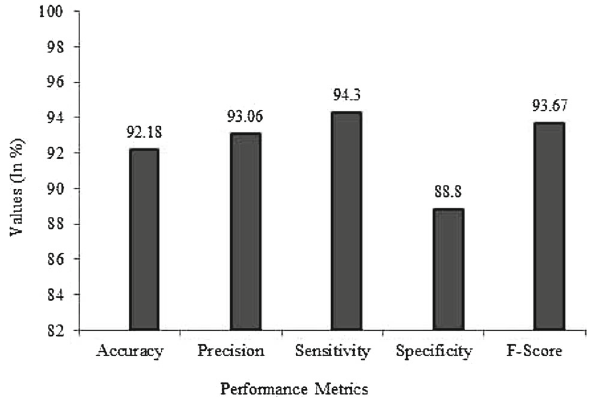
Fig. 4 Performance analysis of the model